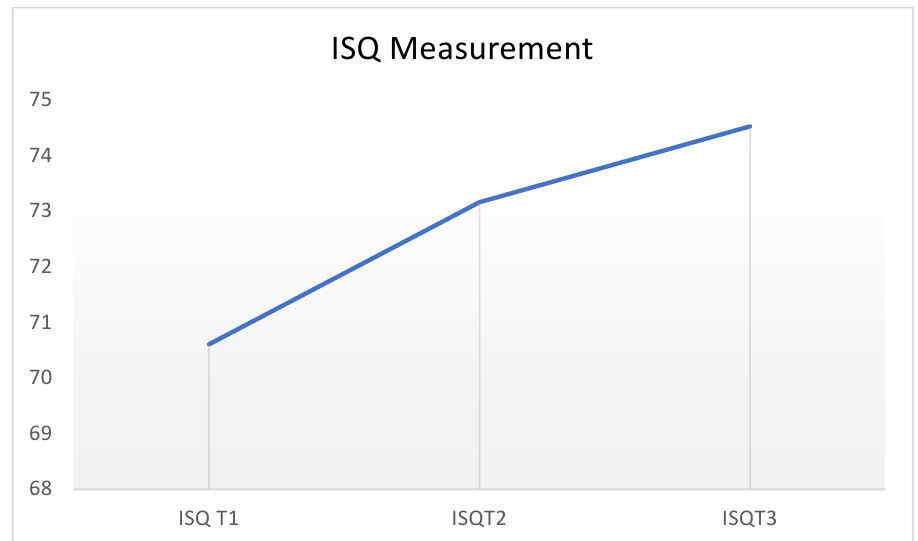
Figure 6. ISQ values at the three measurement times performed.